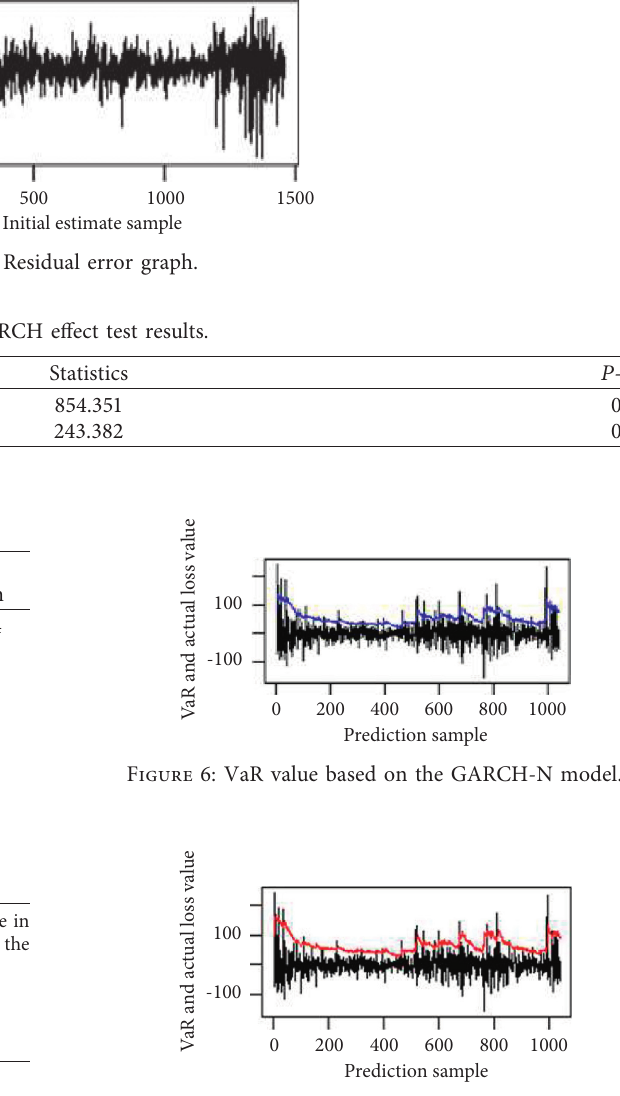
Figure 7: VaR value based on the GARCH-t model.